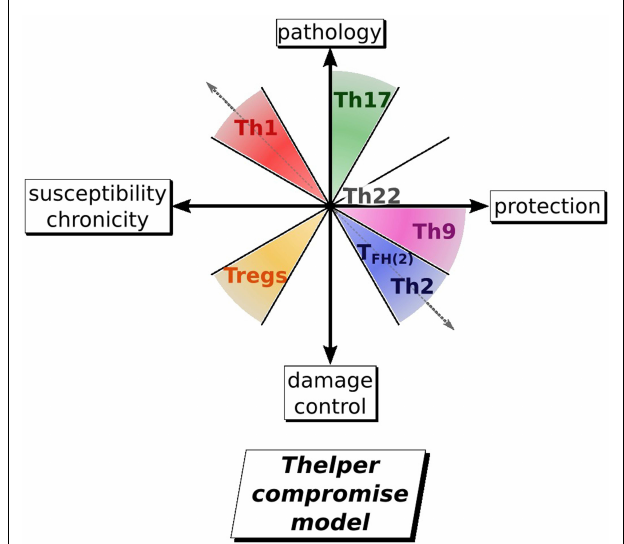
FIGURE 3 | Evolution of the view onT helper involvement in helminth infection . By taking into account all the otherT helper subset known to date, it is proposed that an immune response against on helminth can be summarized as a 2D map defined by an axis of susceptibility/protection and an axis of pathology/damage control. For an optimal response against a parasite, the host would thus mount aTh2/Th9 response with a lowTregs response and almost not existingTh1,Th17 response.TheTh2 arm of the immune response protects against helminth by expanding ILCs, eosinophils and basophils all involved in parasite expulsion or by activating macrophages in AAM, playing a role in granuloma formation.Th9 rather protects by increasing goblet cells hyperplasia and muscle contractility in the gut.Th17 induced pathology is mainly mediated by neutrophils and inflammatory macrophages. In contrary,Tregs induced development of regulatory macrophages, which control